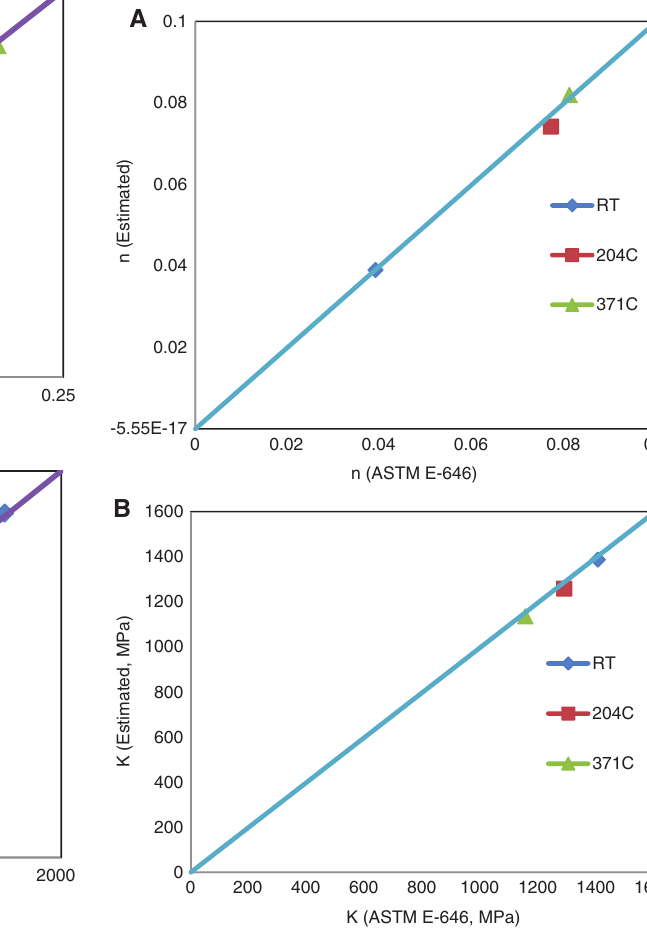
Figure 5 Comparison of present methodology with ASTM E-646 for (A) strain hardening exponent and (B) strength co-efficient for aeroengine materials from test data.